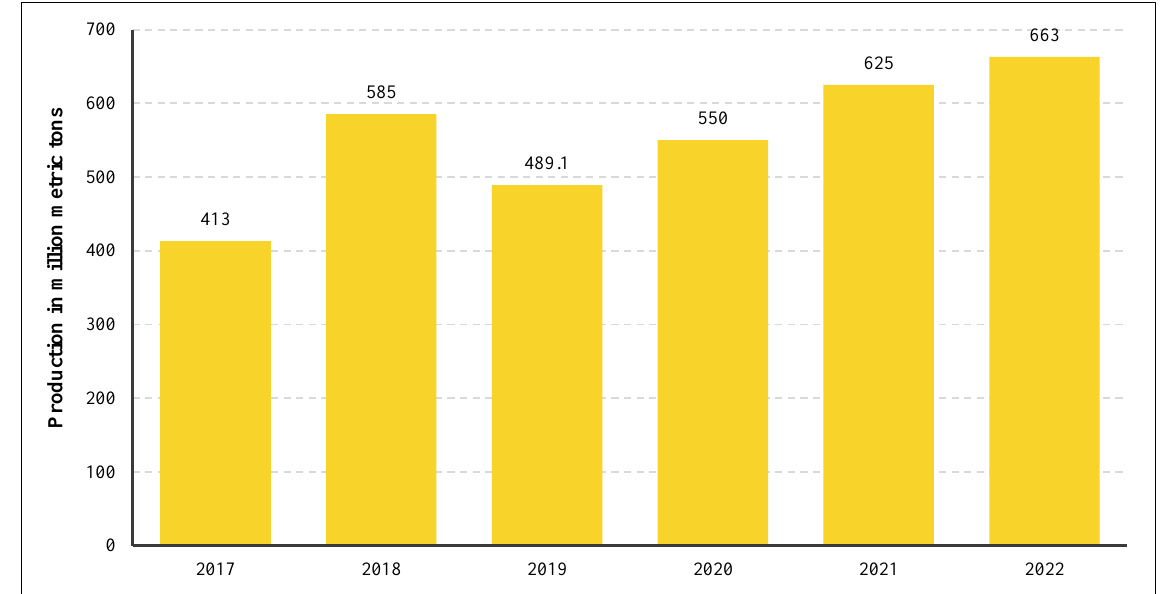
Figure 7. Indonesia’s coal production [35]